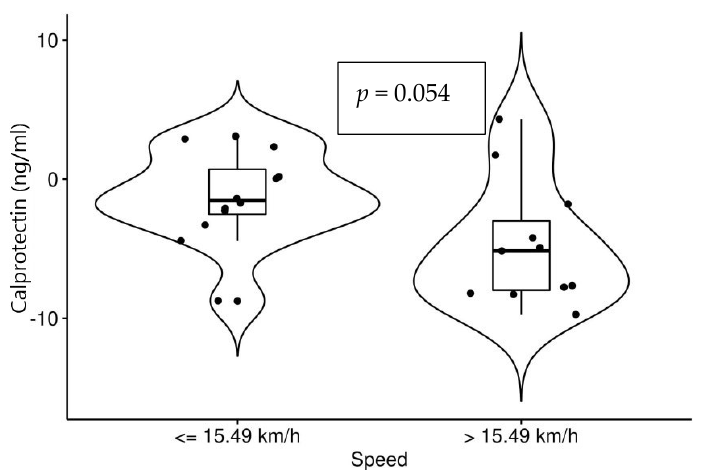
Figure 3. Changes in values of calprotectin (after races − before races) in horses of slower (12 horses) and higher speed (11 horses) .